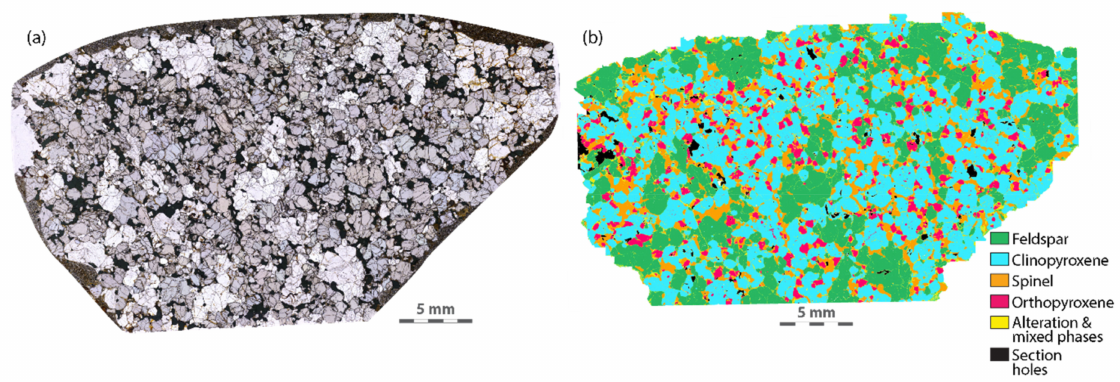
Figure 6. ( a ) Transmitted light image of a lower crustal xenolith from central Queensland, Australia showing massive, granoblastic textures; ( b ) an SEM-EDS phase map of the same